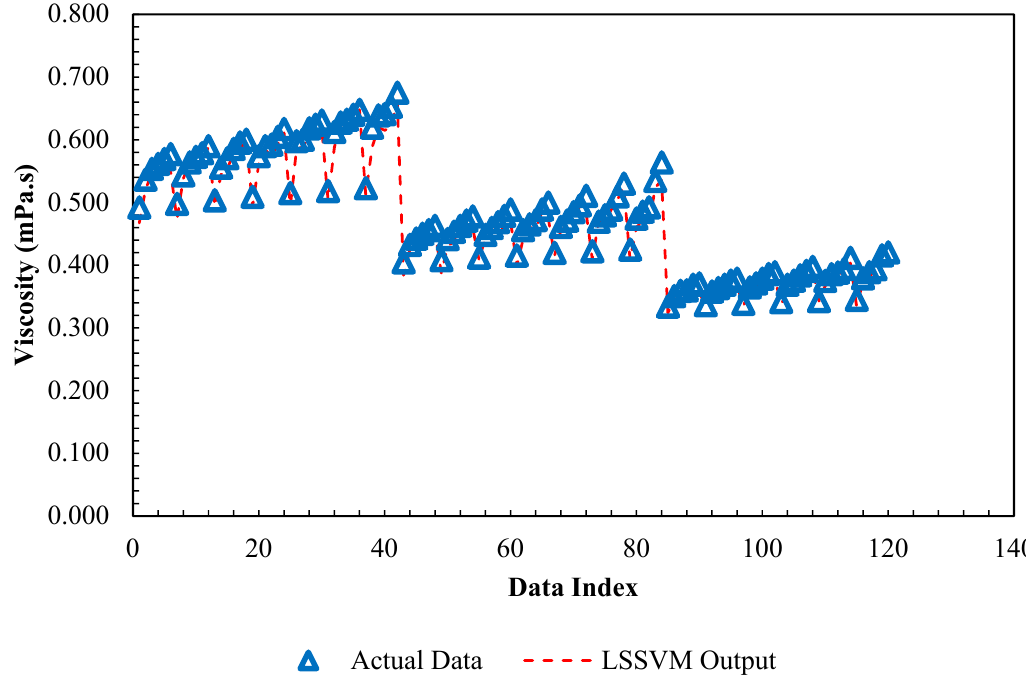
Figure 16. Comparison between actual thermal conductivity of Fe 2 O 3 /ethylene glycol-water nanofluid and predicted values by LSSVM model versus relevant data index.